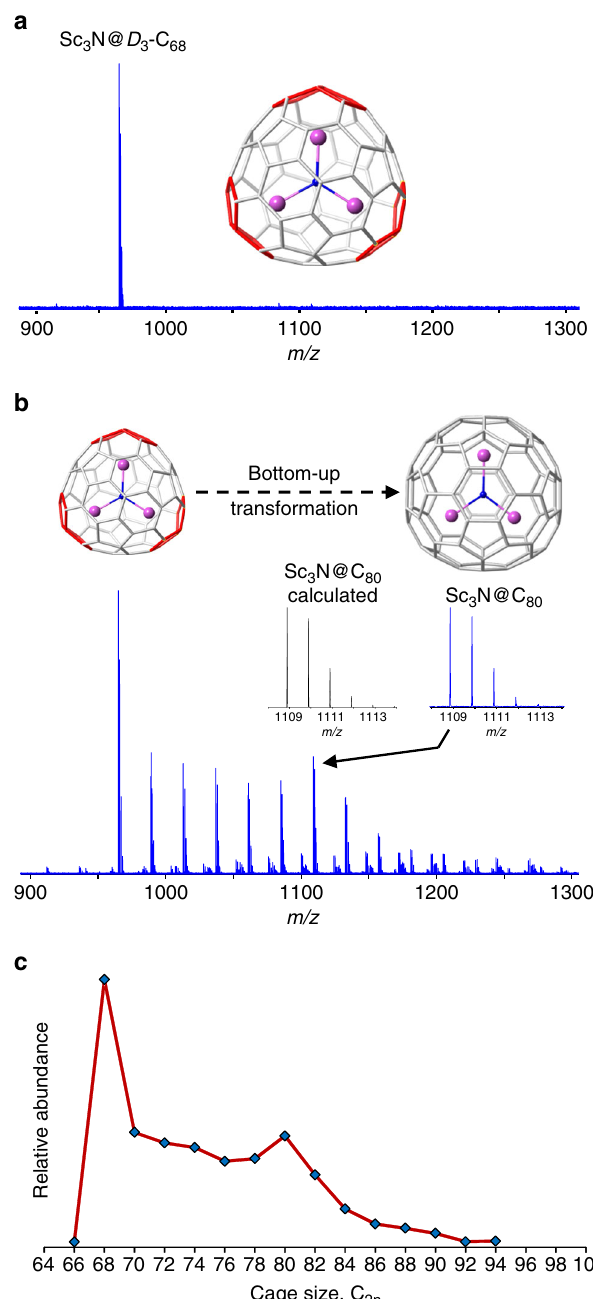
Fig. 2 Bottom-up growth of a small, fused pentagon-containing clusterfullerene. a Low energy (~2 mJ) laser desorption spectrum (positive ions) of isomerically pure, Sc 3 N@ D 3 -C 68 , without exposure to carbon vapor from graphite. b Molecular reactivity and behavior of Sc 3 N@C 68 in carbon vapor from graphite in a He atmosphere (~10 mJ per pulse). c